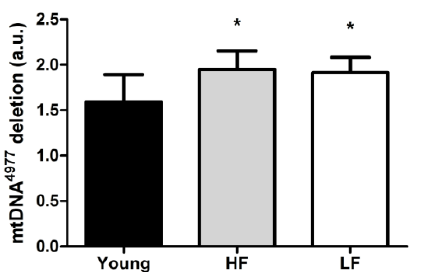
Figure 6. Relative abundance of the mtDNA 4977 deletion in the vastus lateralis muscle of young and old participants. Differences among groups were assessed by one-way ANOVA. Bars represent mean values ( ± standard deviation) for the three experimental groups. Values are expressed in arbitrary units (a.u.). * p < 0.05 vs. young group ( n = 11); HF: high-functioning ( n = 16); LF: low-functioning ( n = 7).